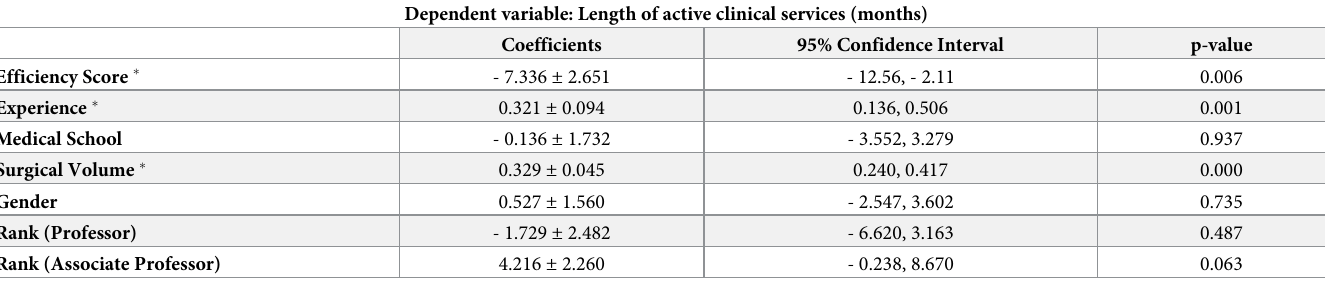
Table 2. Results of multiple regression analysis using an ordinary least squares